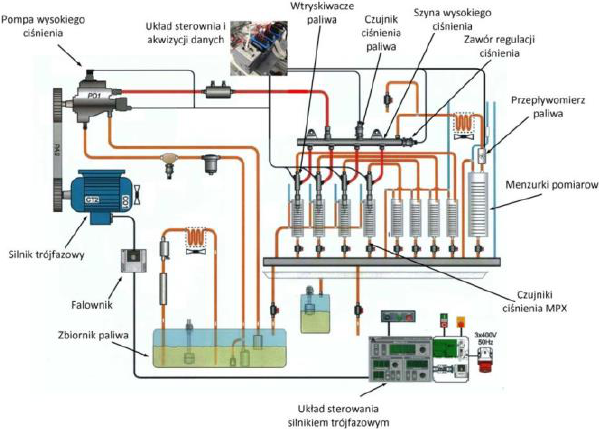
Fig. 2. Diagram of the test bench for testing Common Rail system compo- nents [28]